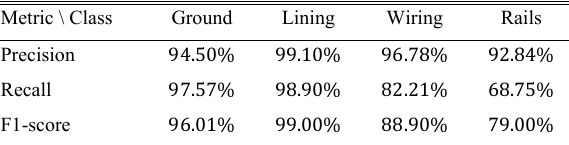
79.00% Table 3. Classification metrics for the KPConv transfer learning results including precision, recall and F1-score. Figure 3 includes the prediction, ground truth and misclassified points for one section in Tunnel A and another in Tunnel B. These figures show that the point clouds are properly segmented overall, with discrepancies mostly around the boundaries of the different